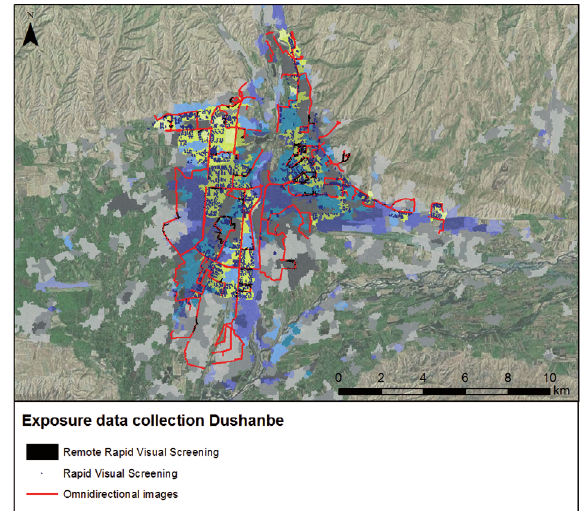
Figure 4. Exposure data collected at L3 for the city of Dushanbe,